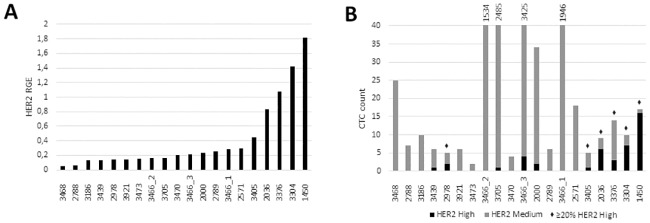
HER-2 protein (ACCEPT) versus mRNA (qRT-PCR) expression of MBC patient samples.A. Increasing ERBB2 (HER-2) relative gene expression (RGE) corrected for CTC content of 20 patient samples with ≥5 CTCs. B. Corresponding HER-2med and HER-2high expressing CTC count by ACCEPT of 20 patient samples with ≥5 CTCs. For four samples the total number of HER-2med expressing cells is given on top. For six samples ≥20% of total CTC count were HER-2high expressing CTCs (◆).